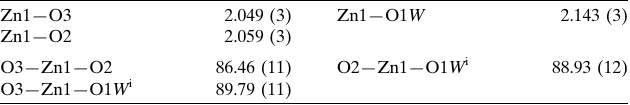
Selected geometric parameters (A˚ , (cid:1) ).